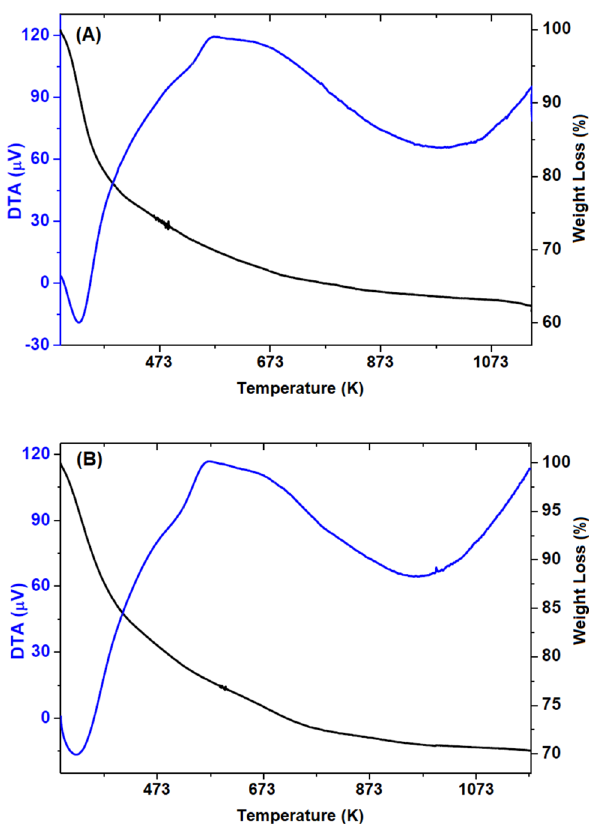
Figure 3. Thermogravimetric analysis of SiTiNb-A (A) and SiTiNb-B (B) . The graphs show the DTA data (blue line) and the relative weight loss (black